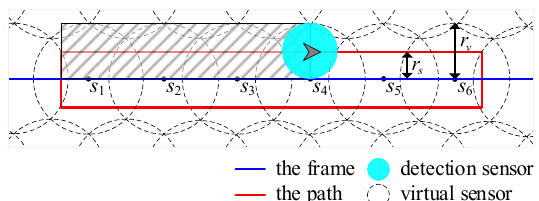
Figure 5. An example of sensor deployment. The radius of each robot is r s and the radius of the virtual sensor is r v . The shaded area represents the field that robots have scanned.